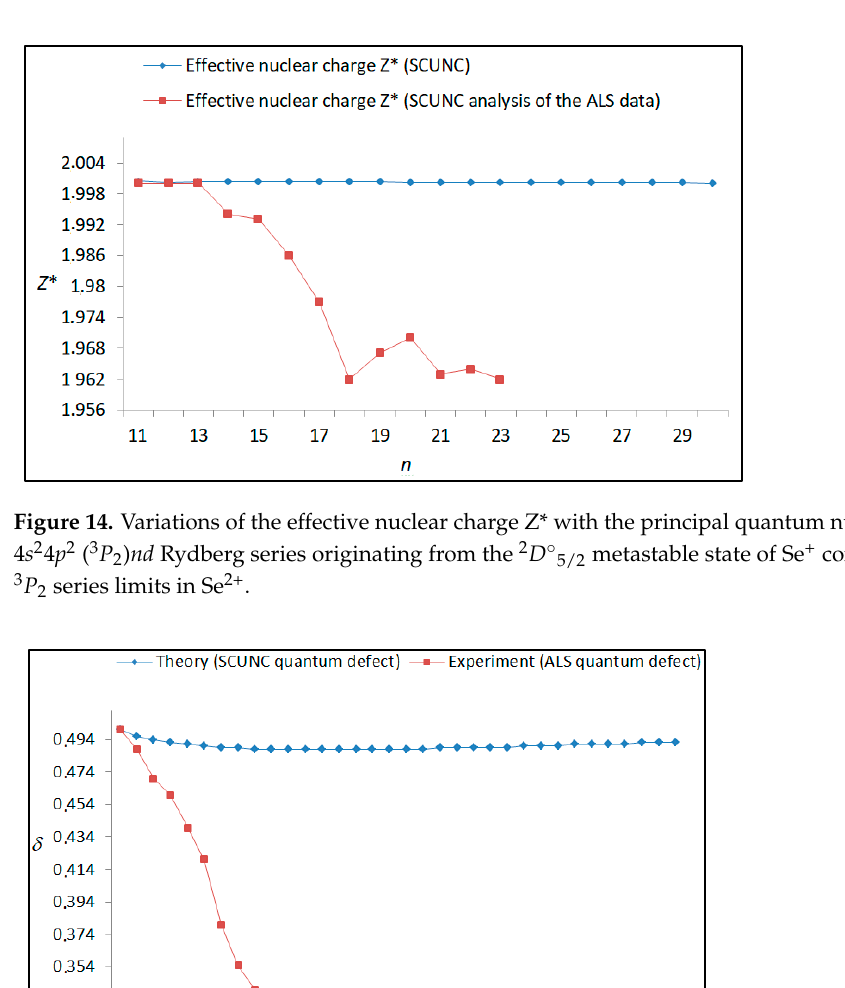
Figure 13. Variations of the quantum defect ( δ ) with the principal quantum number n for the 4 s 2 4 p 2 ( 3 P 2 ) nd Rydberg series originating from the 2 D ° 5/2 metastable state of Se + converging to the 3 P 2 series limits in Se 2+ .